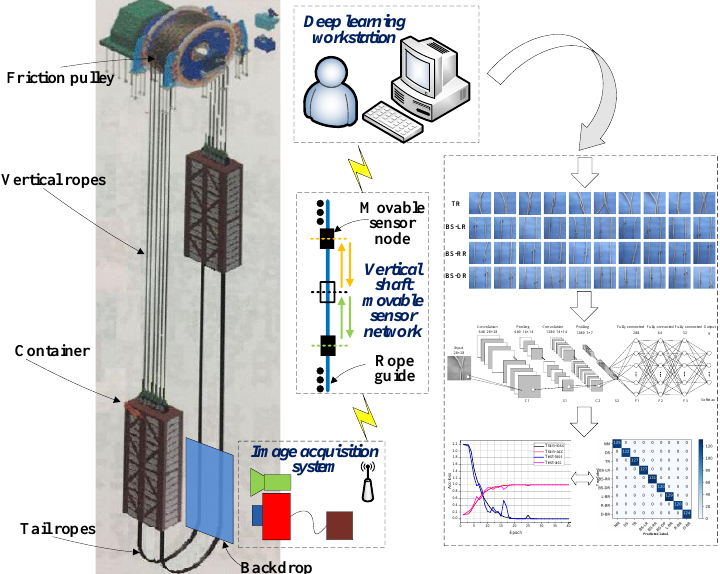
Figure 1. The monitoring system framework based on image data.